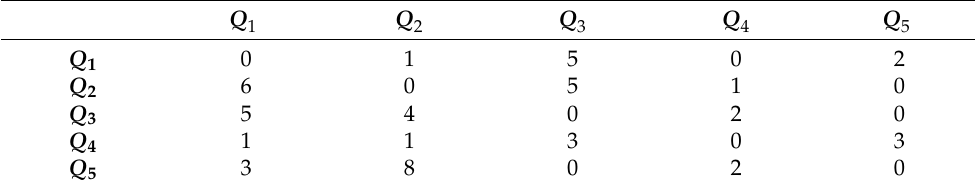
Table 2. Exampl e of Q&A set occurrence dependency